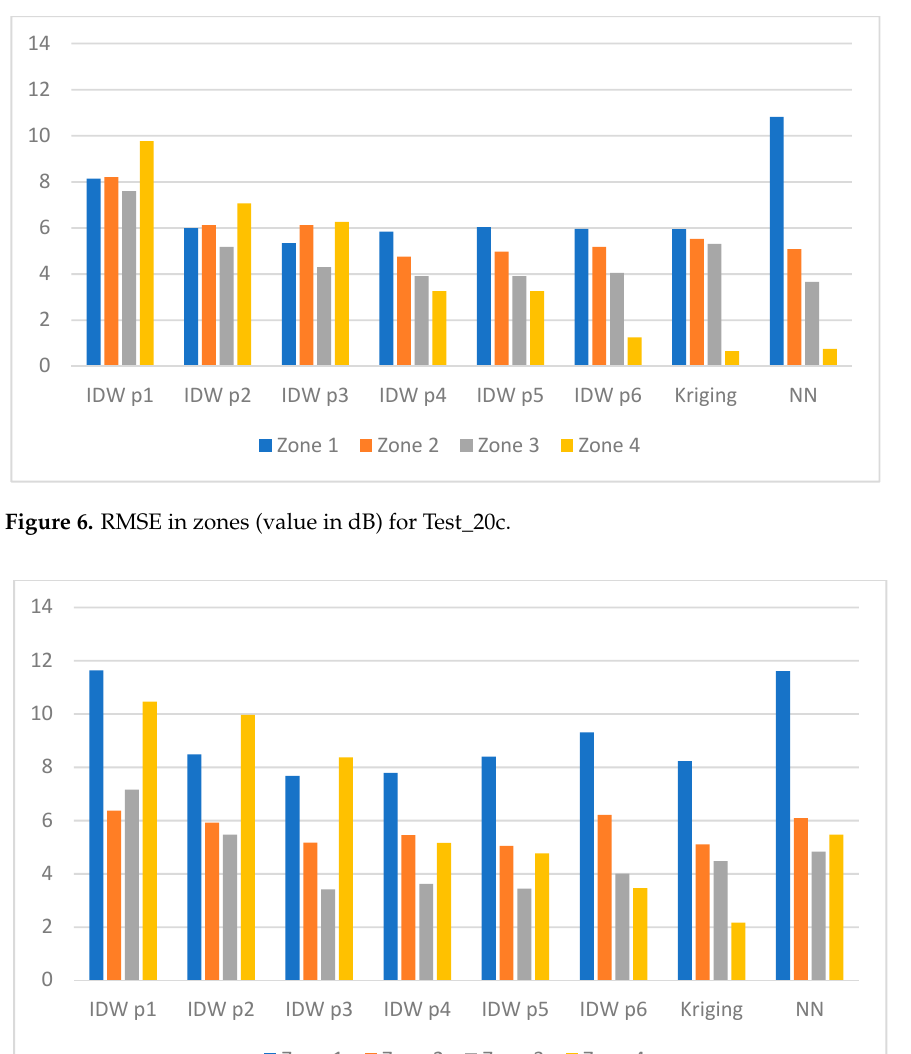
Figure 5. RMSE in zones (value in dB) for Test_13a.